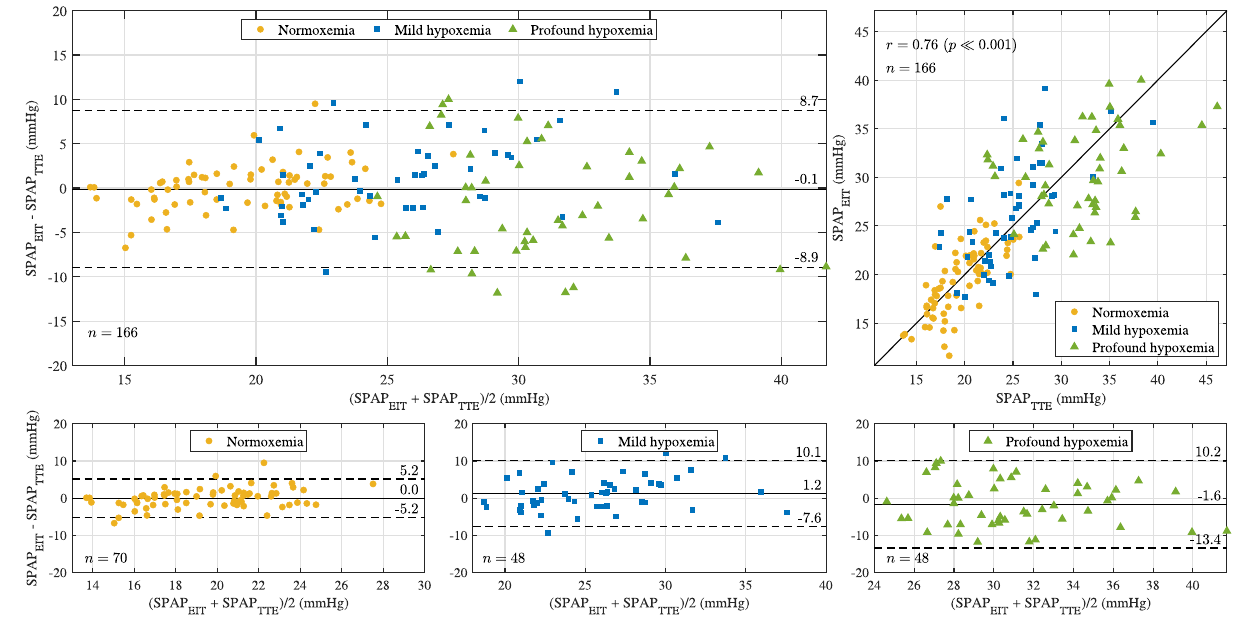
Figure 2. Upper left: Bland–Altman plot depicting the cohort-wise agreement between the EIT-derived SPAP (SPAP EIT ) and the TTE-derived SPAP (SPAP TTE ). Each type of symbol represents an oxygen saturation level (SpO 2 ), showing n = 70 paired values in normoxemia (filled circle, SpO 2 ≥ 95%), n = 48 paired values in mild hypoxemia (filled square, 90% > SpO 2 ≥ 80%), and n = 48 paired values in profound hypoxemia (filled triangle, 80% > SpO 2 ≥ 65%), for a total of n = 166 paired values. In terms of accuracy, an average difference (bias) of − 0.1 mmHg was found between both methods and is depicted as a solid line. In terms of precision, the standard deviation (SD) of the paired differences was found to be 4.5 mmHg, resulting in 95% limits of agreement (bias ± 1.96 SD) of [− 8.9, 8.7] mmHg, depicted as dashed lines. Upper right: Correlation plot between SPAP EIT and SPAP TTE , with a cohort-wise Pearson’s correlation coefficient of 0.76 (P Bland–Altman plots for each SpO 2 level separately. EIT electrical impedance tomography, TTE transthoracic echocardiography, SPAP systolic pulmonary artery pressure.